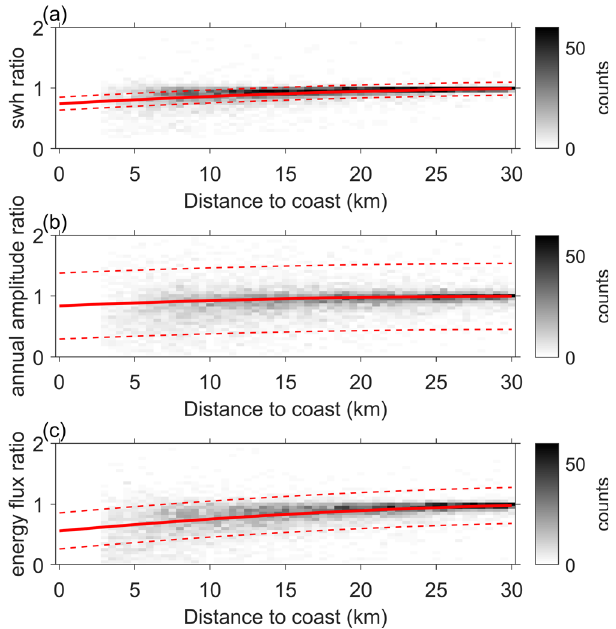
Fig. 6 Global coastal attenuation. Density plots of the ratios between wave parameters computed in the coastal zone over the globe and the corresponding parameter computed offshore. The parameters considered are the mean Signi fi cant Wave Height (SWH) ( a ), the amplitude of the annual cycle ( b ), and the average wave energy fl ux ( c ). A second-degree polynomial is fi tted to the data and plotted in red. The 95% con fi dence interval of the fi t is shown with red dashed